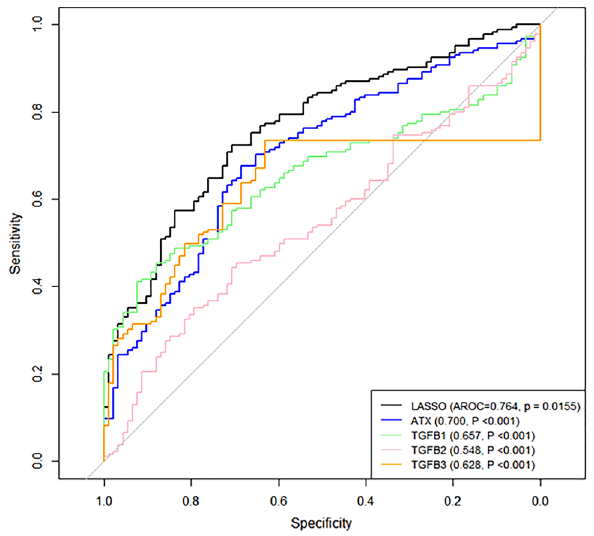
Figure 2. ROC curves with row values for ATX, TGF-β1, TGF-β2, TGF-β3 produced using LASSO regression. The AUC values produced by LASSO were significantly larger compared with the row values of ATX, TGF-β1, TGF-β2, and TGF-β3 ( P < 0.05). ROC, receiver operating characteristic; LASSO, least absolute shrinkage and selection operator; AUC, area under the receiver operating characteristic curve.